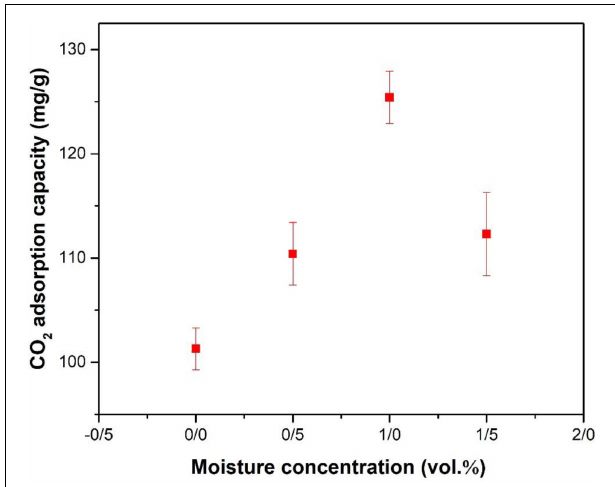
FIGURE 11 | Effect of moisture on CO 2 adsorption capacity at 70 ◦ C in the presence of 0.5, 1, 1.5 vol.% of the H 2 O moisture.